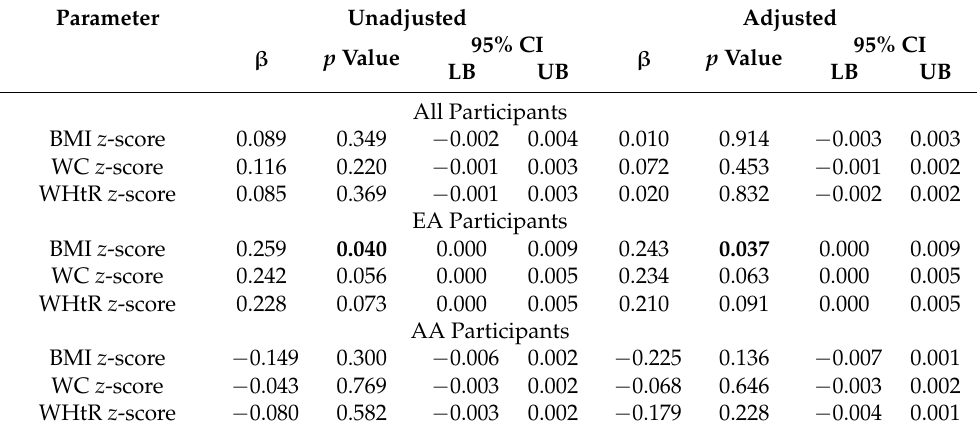
Table 5. Hierarchical regression analysis of obesity measures and PMR of NRF1 .